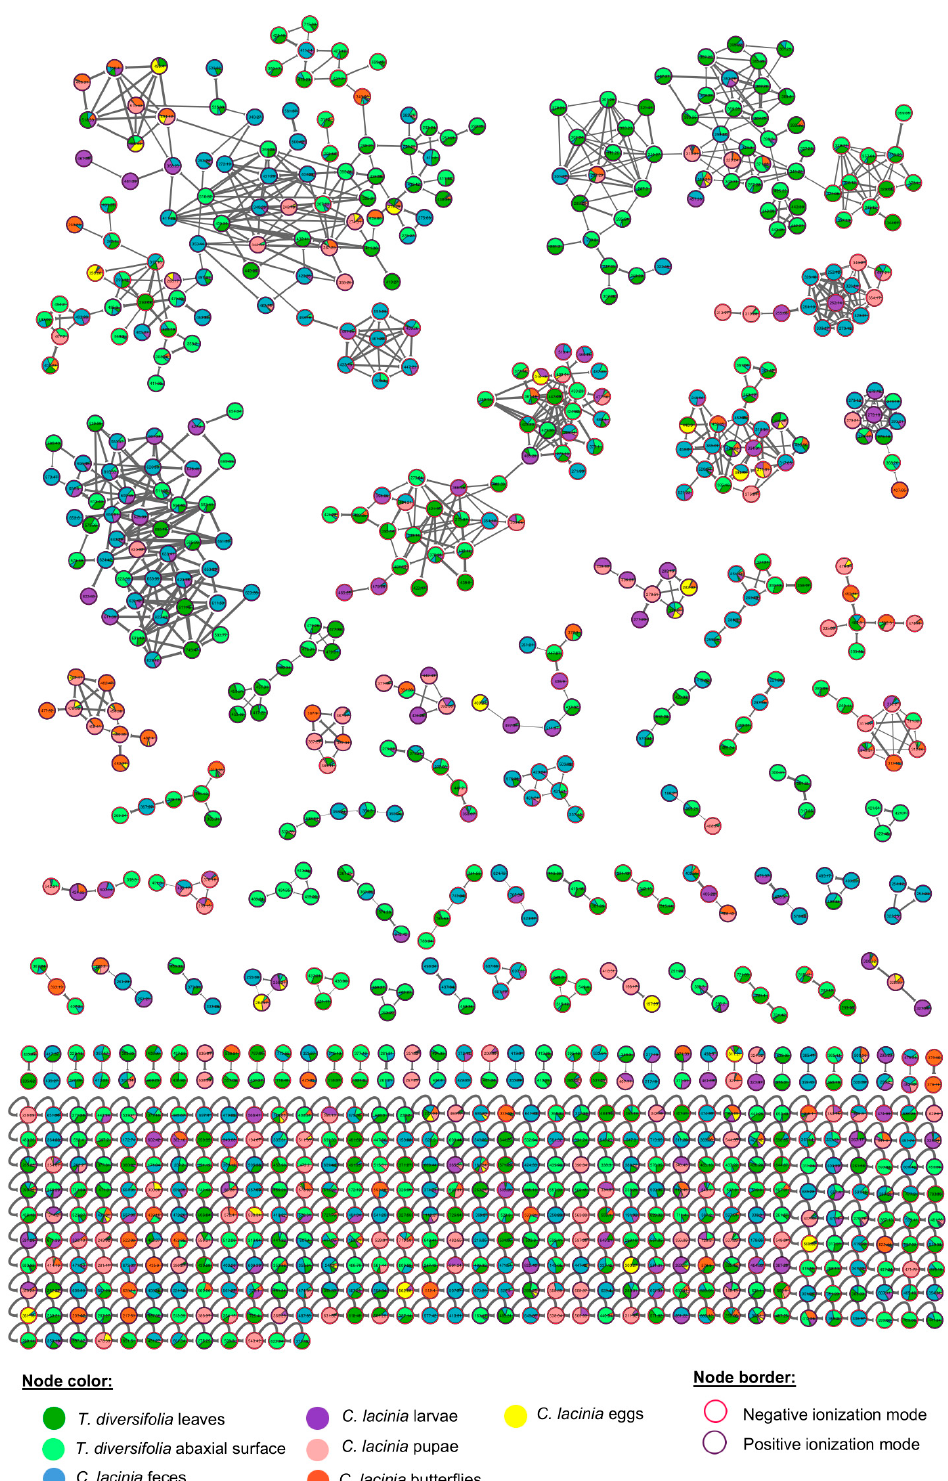
Figure 2. Molecular networking of T. diversifolia and C. lacinia samples analyzed by LC-MS n (IT) in the positive and negative ionization modes. Nodes represent detected compounds and are colored according to the type of sample. Borders of the nodes are colored according to the ionization mode in which the mass feature was obtained. Edges between nodes represent molecular structural similarity between compounds. Nodes without GNPS spectral library matching with other nodes are represented as self-loops (bottom), i.e., edges from a vertex to itself.